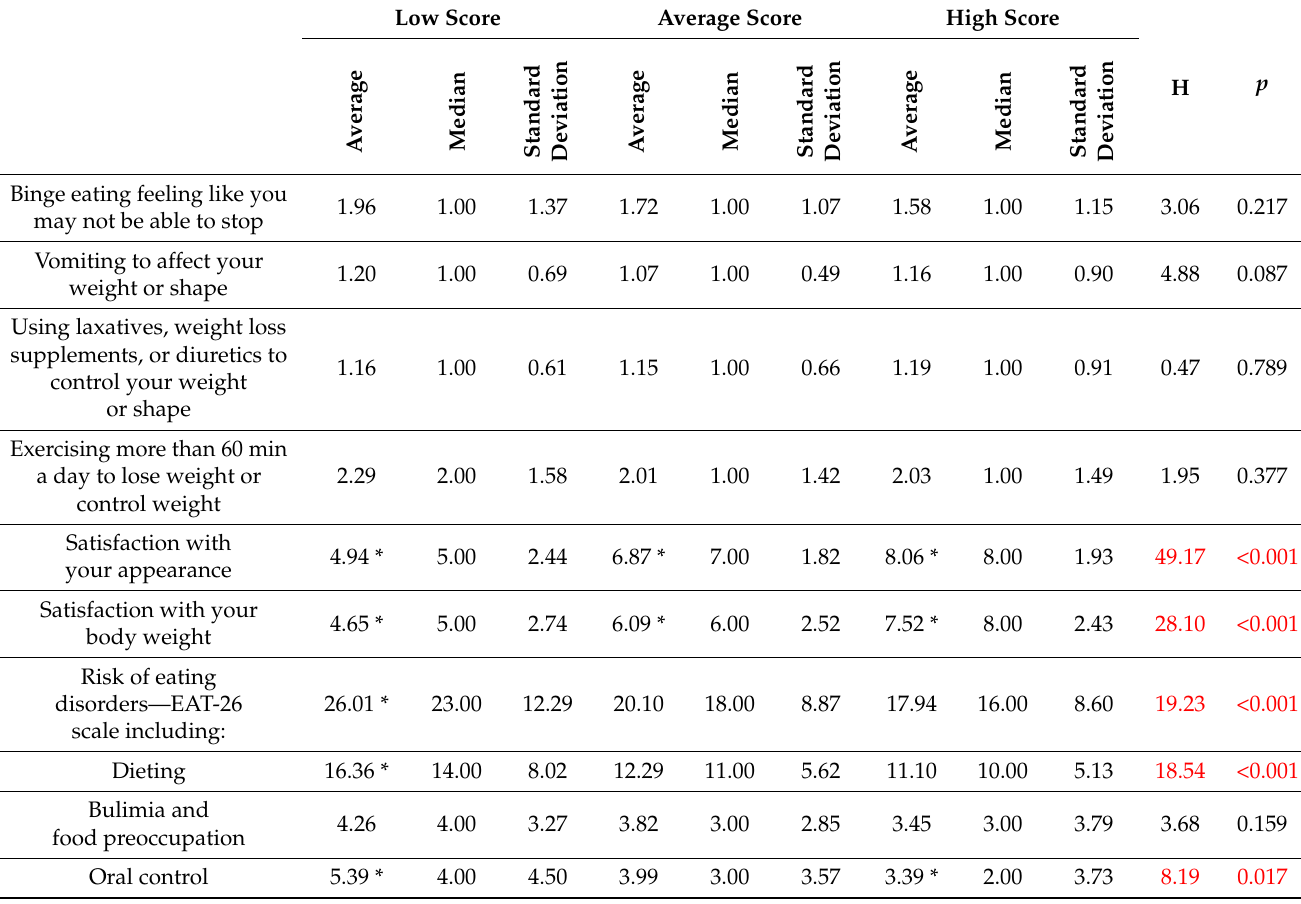
Table 4. The influence of self-esteem on the selected questions. Low